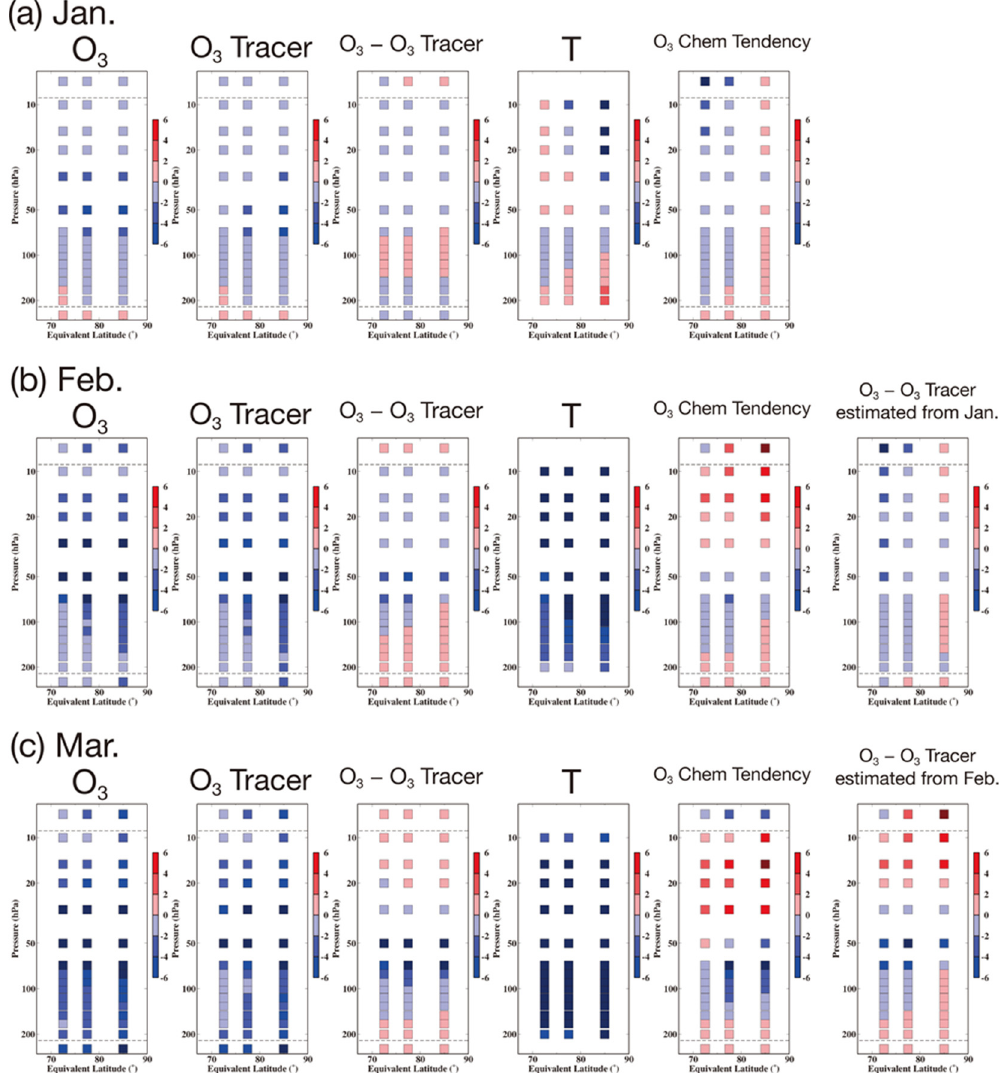
Figure 14. Same as Figure 8, but for the partial column anomaly in 2011.